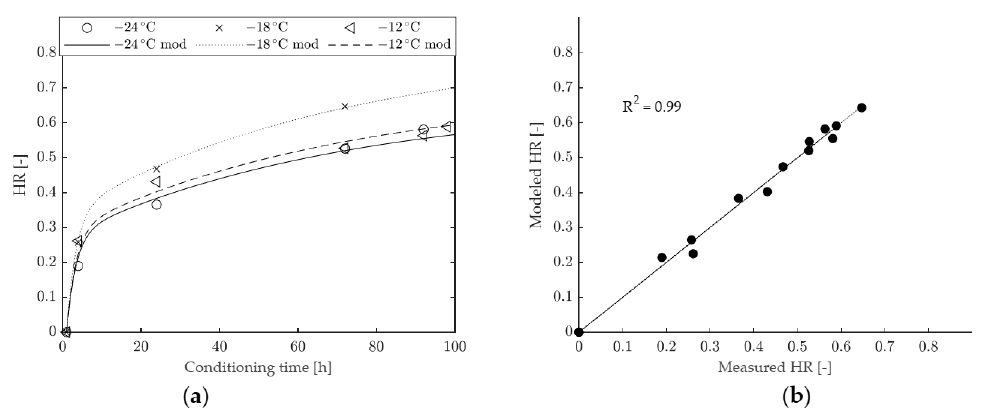
Figure 10. HR of binder A: ( a ) comparison between modeled and experimental data, ( b ) goodness of fit of the improved model.